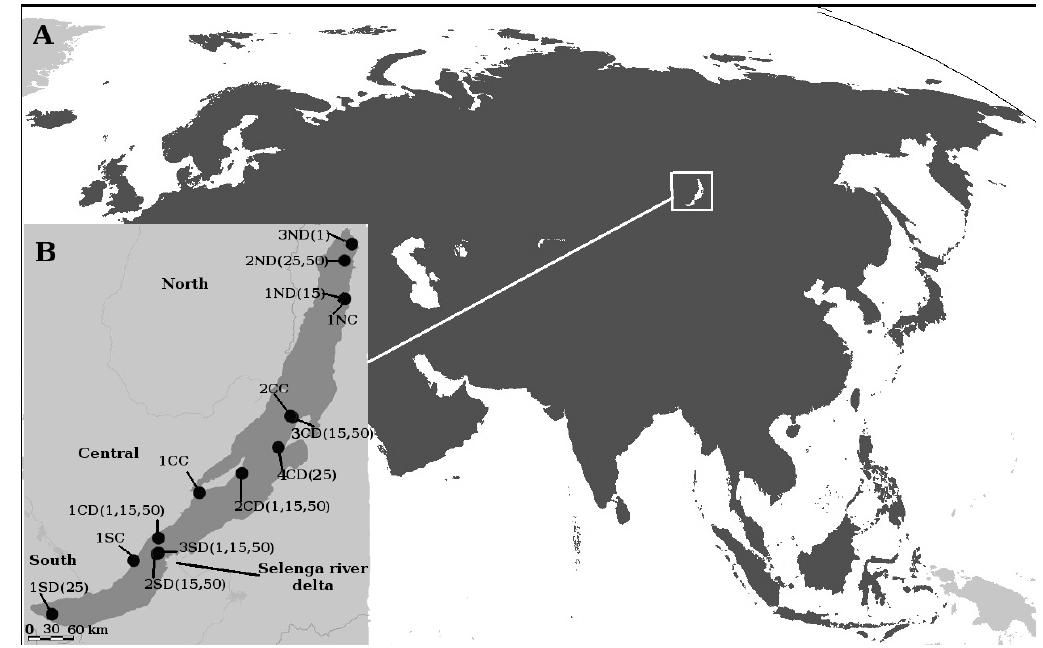
Figure 1. A. Lake Baikal position in Eurasia, B. Sampling sites in Lake Baikal. For each sample, the first number and letter indicates the number within one of the basins (S—Southern, C—Central, N—Northern basins), the second letter indicates coastal (C; up to 40 m depth) or deepwater (D; more than 100 m depth) sites, and numbers within brackets indicate the sample depth (e.g., 1CD (1, 15, 50) means of samples from 1, 15, and 50 m depths that were taken in the first site of the Central basin at a deep site. No depth is shown for the coastal samples.